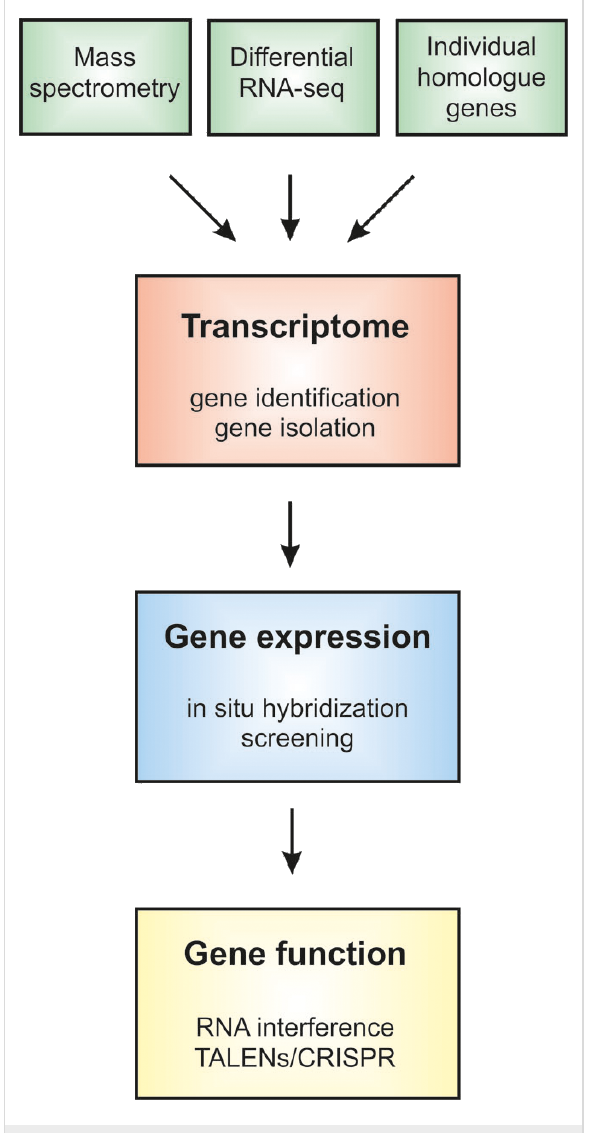
Figure 1: Flowchart showing the transcriptome as a central element to be searched by data generated from various sources, while down- stream analyses also rely on the